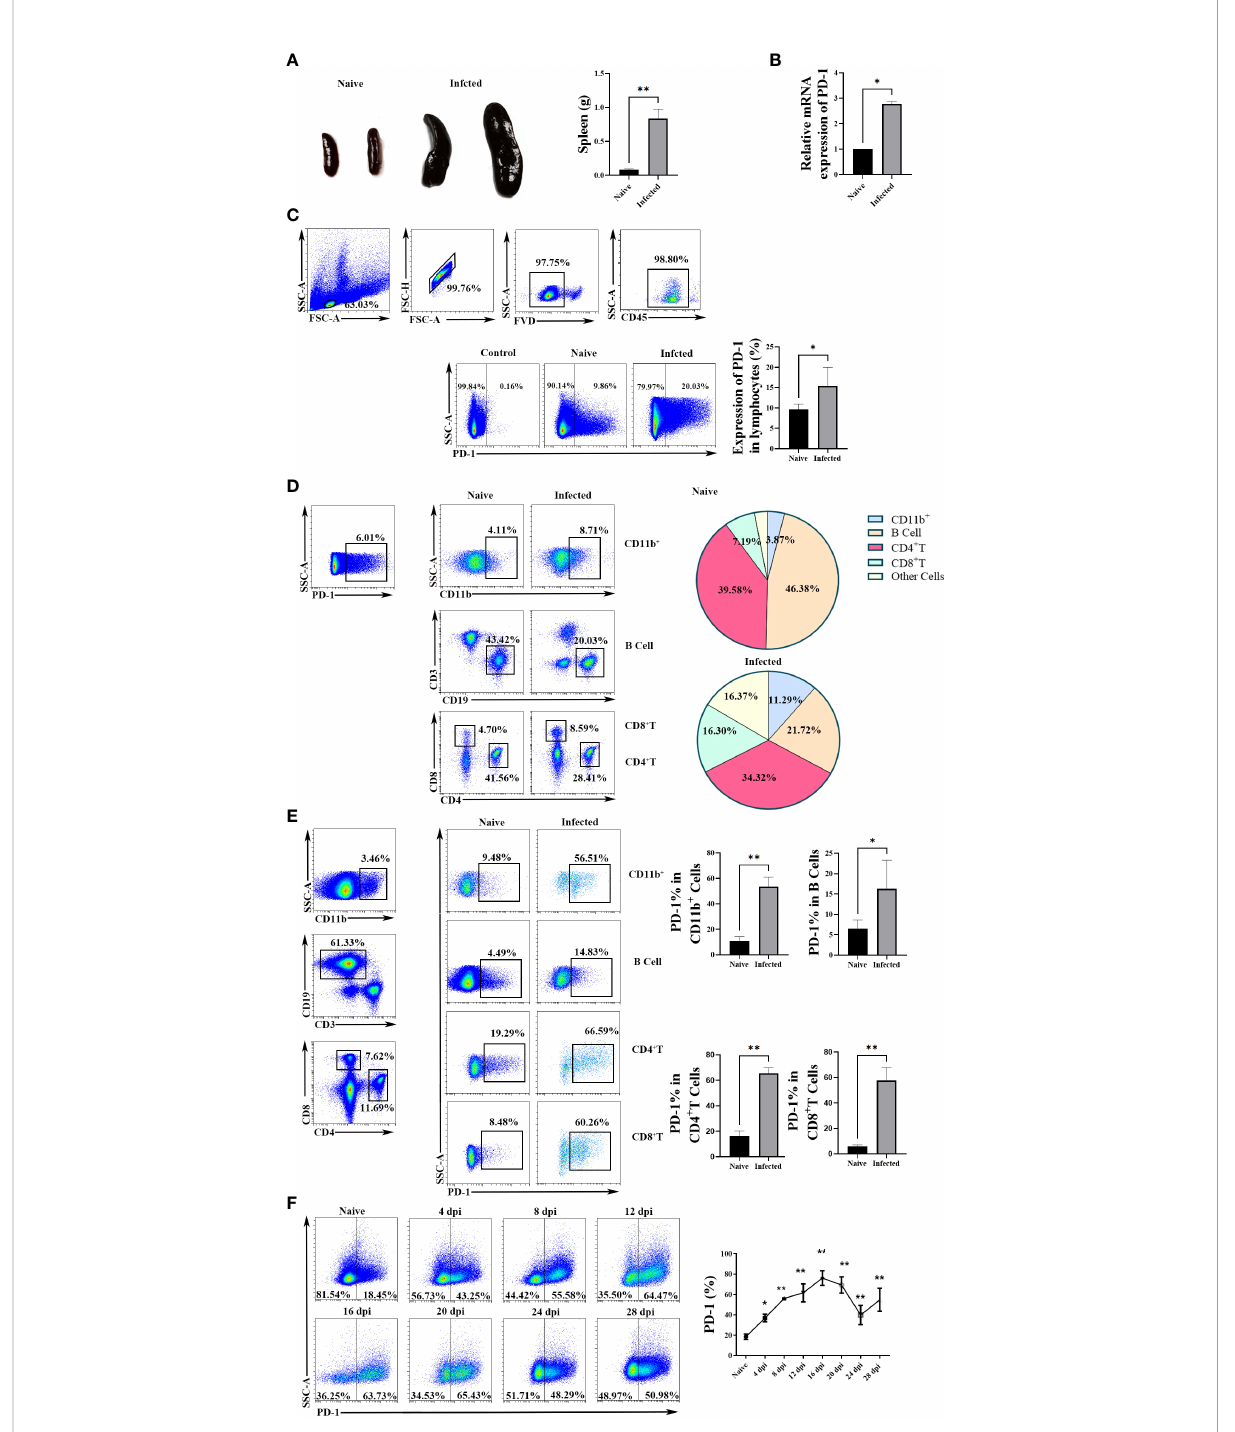
FIGURE 1 The expression of PD-1 in CD4 T cells increased upon P. yoelii infection. (A) the representative spleens from the naive and infected mice and the comparison of splenic weight from the naive and infected mice. PD-1 expression in splenic lymphocytes was tested by qPCR (B) and FCM (C) . (D) the constitutes of splenic PD-1 + cells and their changes after P. yoelii infection were explored by FCM. (E) the proportions of PD-1 + CD4 T cells, PD-1 + B cells, PD-1 + CD11b + cells, and PD-1 + CD8 cells from naive and infected mice were compared. (F) the dynamic changes of splenic PD-1 + CD4 T cells in P. yoelii infected mice were investigated from 0-28 days, and the naive mice were set as control (0 days). 3 – 7 samples were prepared for each group, and the experiments were repeated three times. The error bars represented number of mice. * p <0.05, ** p